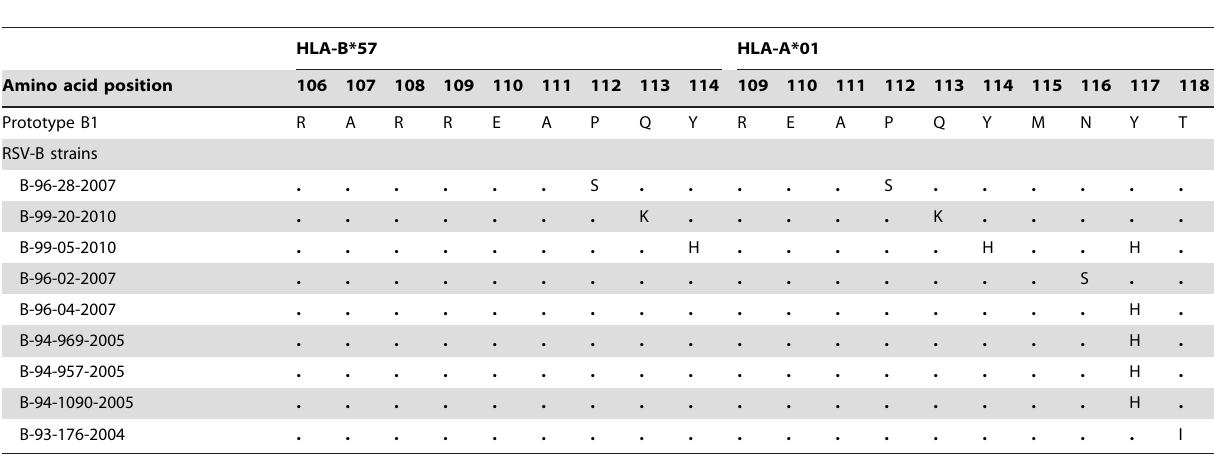
Table 3. Difference of amino acid in CTL-specific epitopes (HLA-B57, HLA-A*01) between RSV prototype (B1) and Taiwan RSV-B